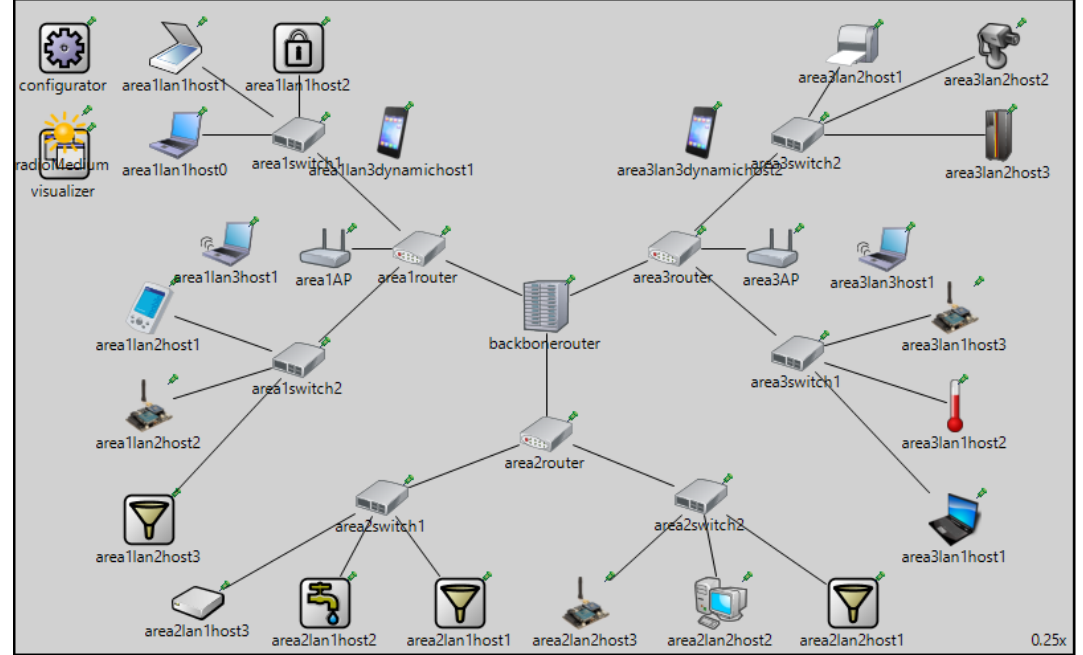
Figure 11. Simulation network